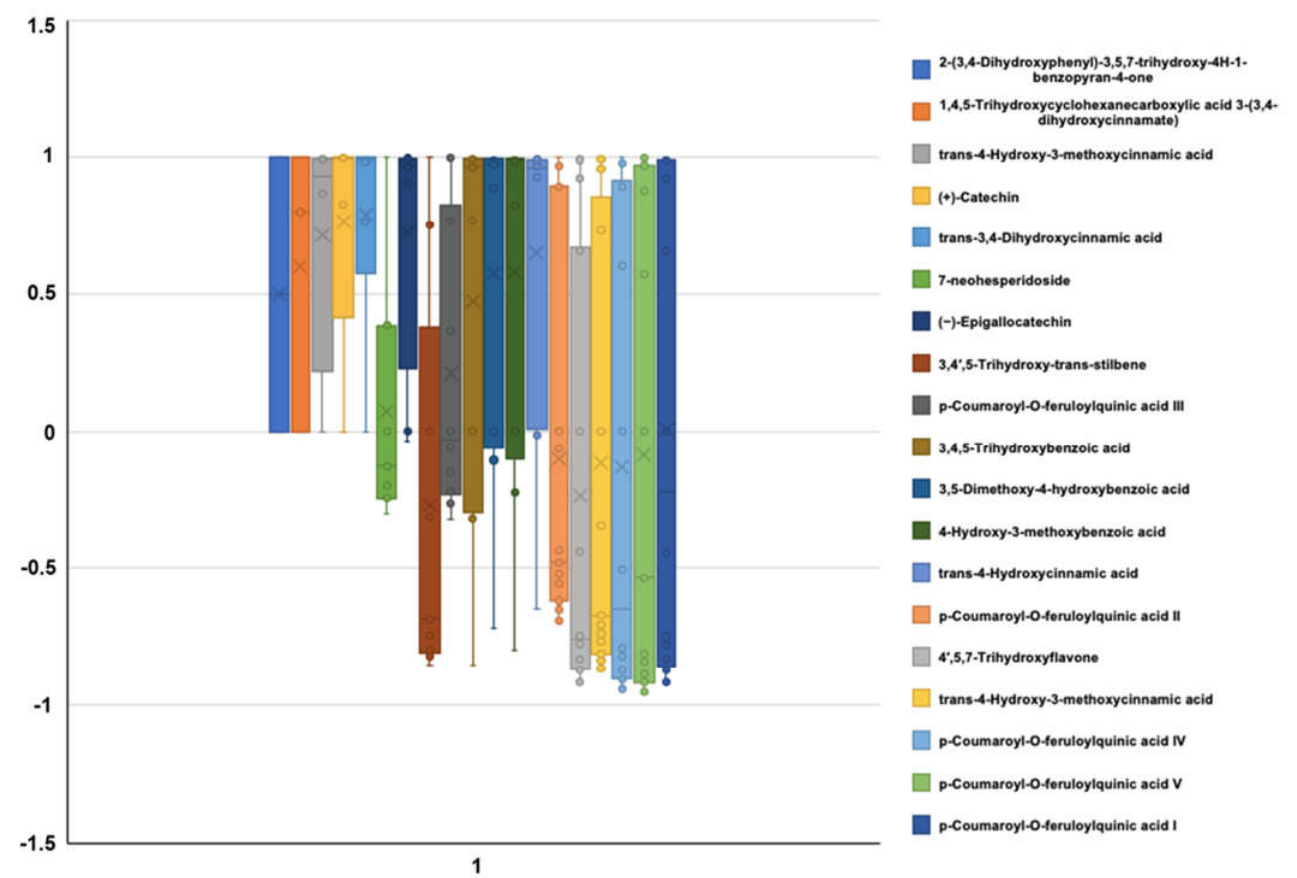
Figure 2. Correlation matrix of the obtained phenolic compound compositions. Table 2. Method calibration and validation parameters for analysis of the phenolic standards.